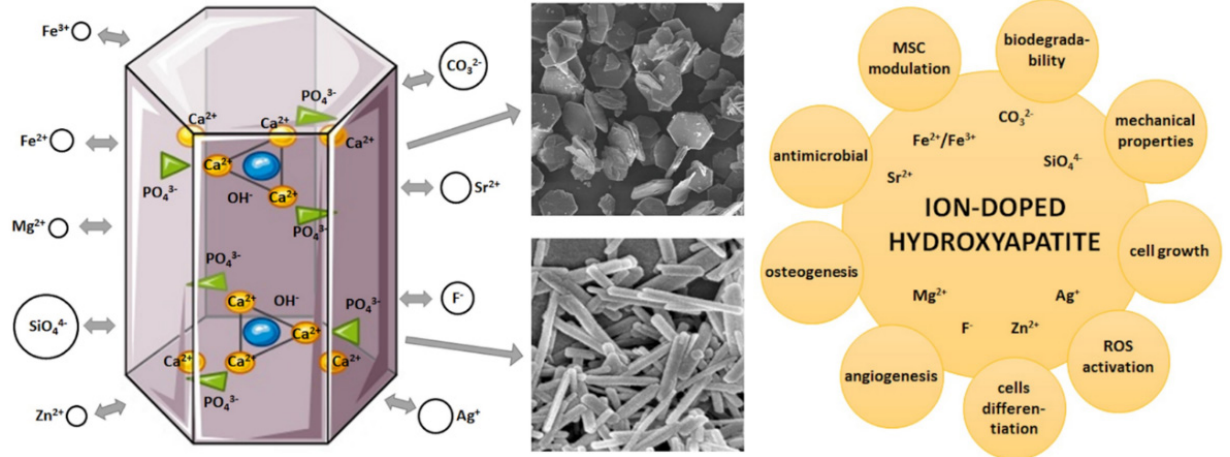
Figure 1. Biomimetic hydroxyapatite: ( left) : crystal structure and multiple ion doping determining different particle nanostructure; ( right) : scheme of the multifunctional applications of apatite nanoparticles.